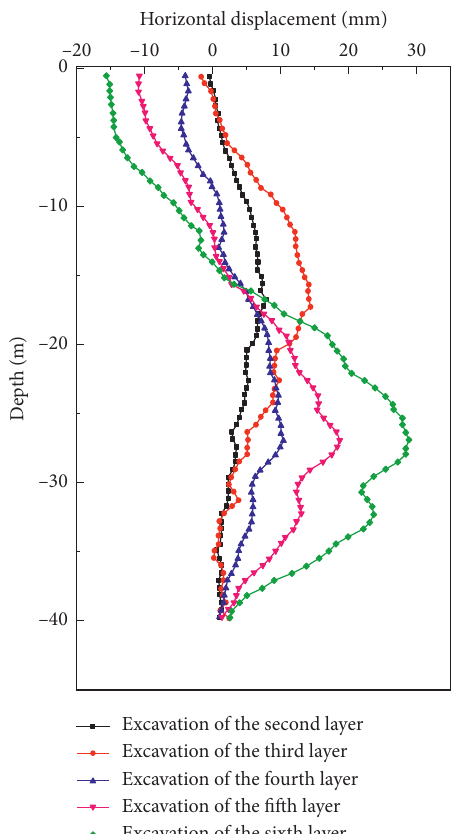
Figure 16: Change of the deep horizontal displacement of the enclosure wall at monitoring point